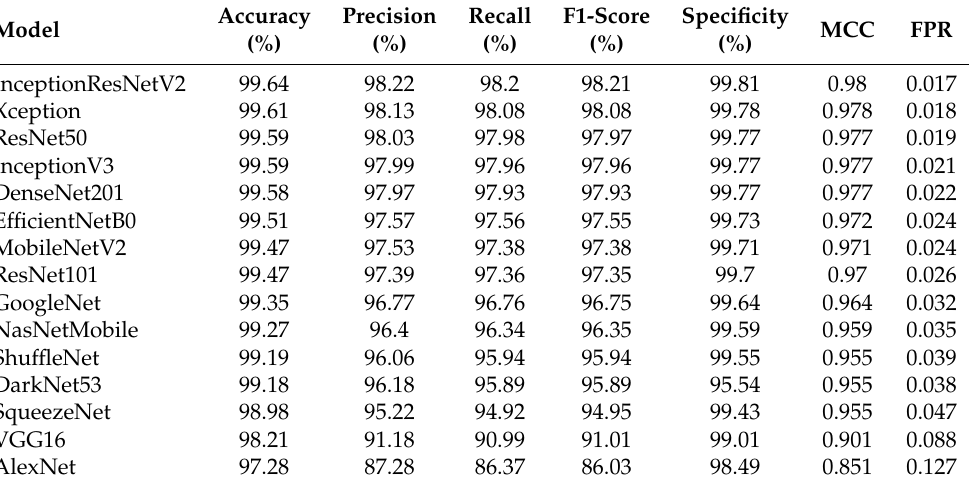
Accuracy Precision Recall F1-Score Specificity MCC (%) (%) (%) (%) (%)